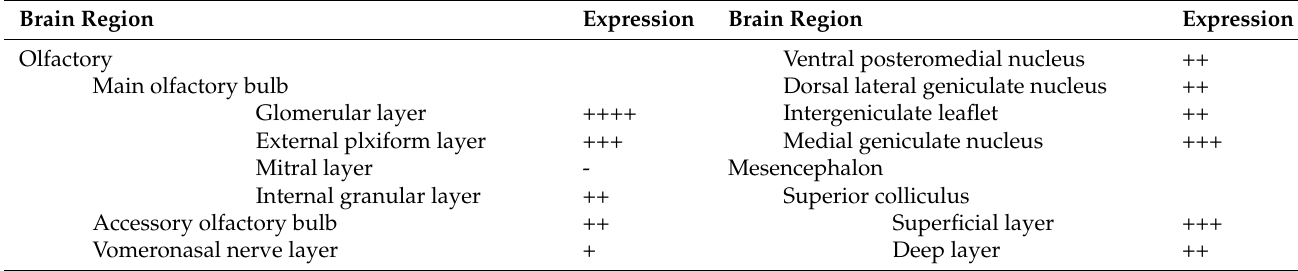
Figure 1. ( A ) Anti-MGRN1 antibody recognized a single band with a molecular weight of 50–60 kDa within the mouse brain membrane fraction (MGRN1 lane). No immunoreactivity was observed in Western blots generated with serum that was pre-absorbed with the synthetic peptide of the epitope (pre-absorbed lane). ( B ) Anti-MGRN1 antibody-detected immunoreactivity in the sagittal sectioned mouse brain as assessed via immunohistochemical staining (MGRN1). No immunoreactivity was observed with serum that was pre-absorbed with the synthetic peptide of the epitope (pre-absorbed). Scale bar in ( B ) = 1 mm. Table 1. Immunohistochemical localization of MGRN1-IR in mouse